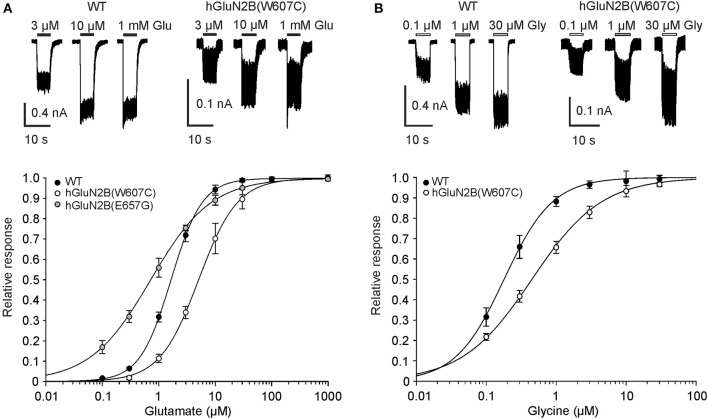
hGluN2B rare variants alter glutamate and glycine potency. (A) Representative recordings of responses to 3, 10, and 1,000 μM glutamate applications made in the presence of 30 μM glycine are shown for HEK293T cells expressing WT and hGluN1/hGluN2B(W607C) receptors. Peak concentration-response relationship for glutamate activation of WT, hGluN1/hGluN2B(W607C; and E657G) receptors. (B) Representative recordings of responses to 0.1, 1, and 30 μM glycine applications made in the presence of 1 mM glutamate are shown for HEK293T cells expressing WT and hGluN1/hGluN2B(W607C) receptors. Peak concentration-response relationship for glycine activation of WT and hGluN1/hGluN2B(W607C) receptors. Data points in (A,B) are averaged values of relative currents form at least five independent measurements. Error bars represent SEM. Values of glutamate and glycine EC50, h and n are listed in Table 2.